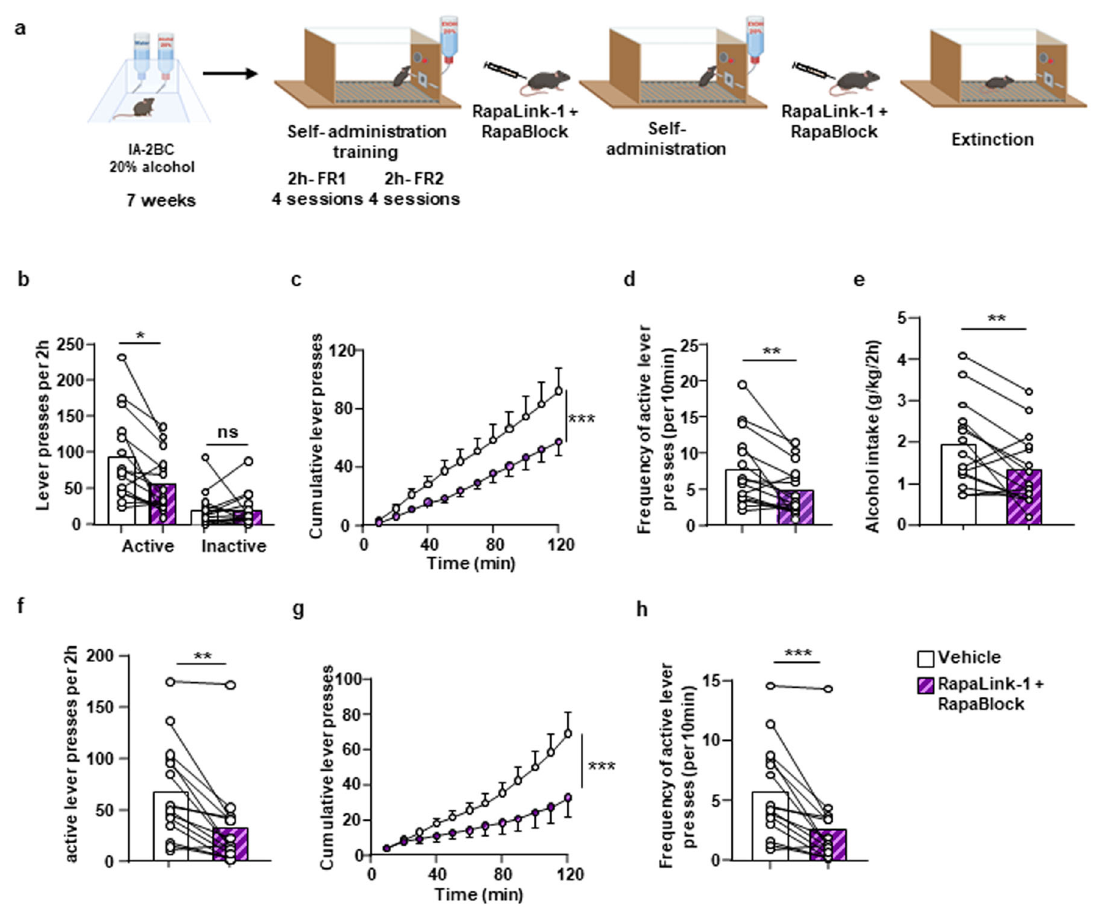
Fig. 6 RapaLink-1 reduces alcohol self-administration and seeking in the presence of RapaBlock. a Timeline of experiment. Mice that underwent 7